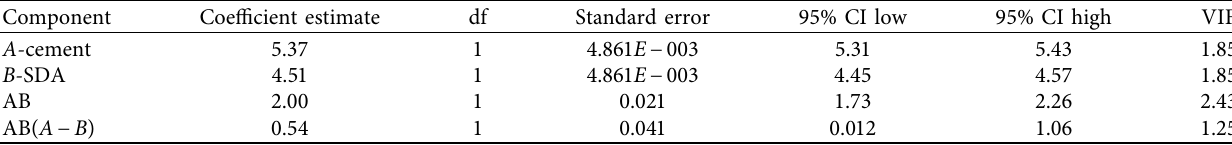
Table 19: Model coefficient calculation results for compressive strength response.